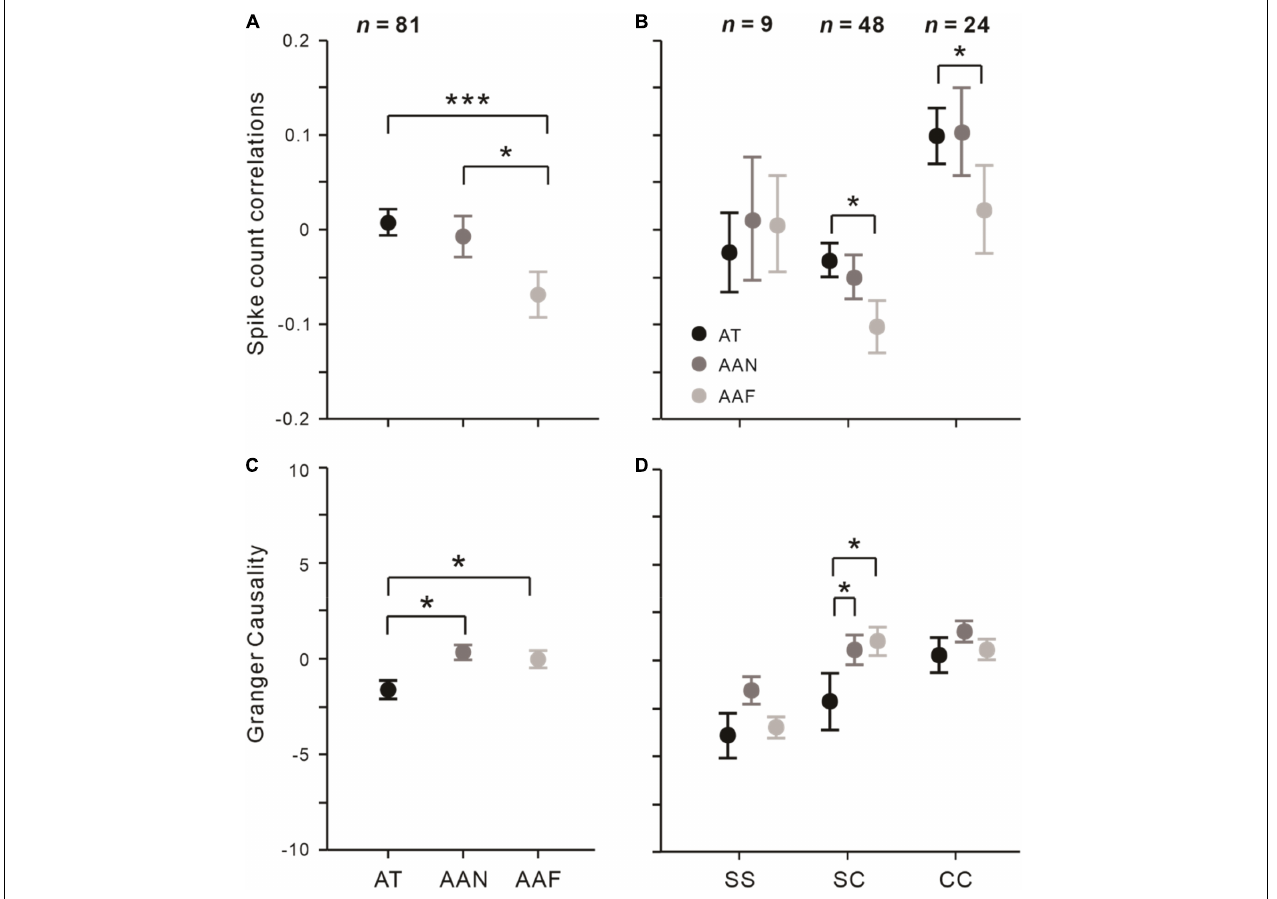
FIGURE 3 | Effects of spatial attention on r sc and Granger causality among different conditions and groups of neuronal pairs. (A) r sc and (C) Granger causality in AT, AAN, and AAF conditions that averaged across all pairs ( n = 81). (B) r sc and (D) Granger causality among SS ( n = 9), SC ( n = 48), and CC ( n = 24) pairs. Error bars represent ± SEM. Repeated-measures ANOVAs and Bonferroni-corrected post hoc analysis, * p < 0.05, *** p < 0.001.